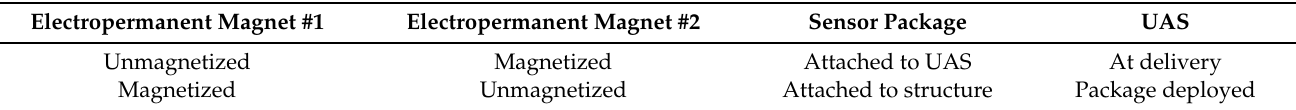
Table 2. Operation status for Electropermanent Magnets #1 and #2 for each sensor package and UAS